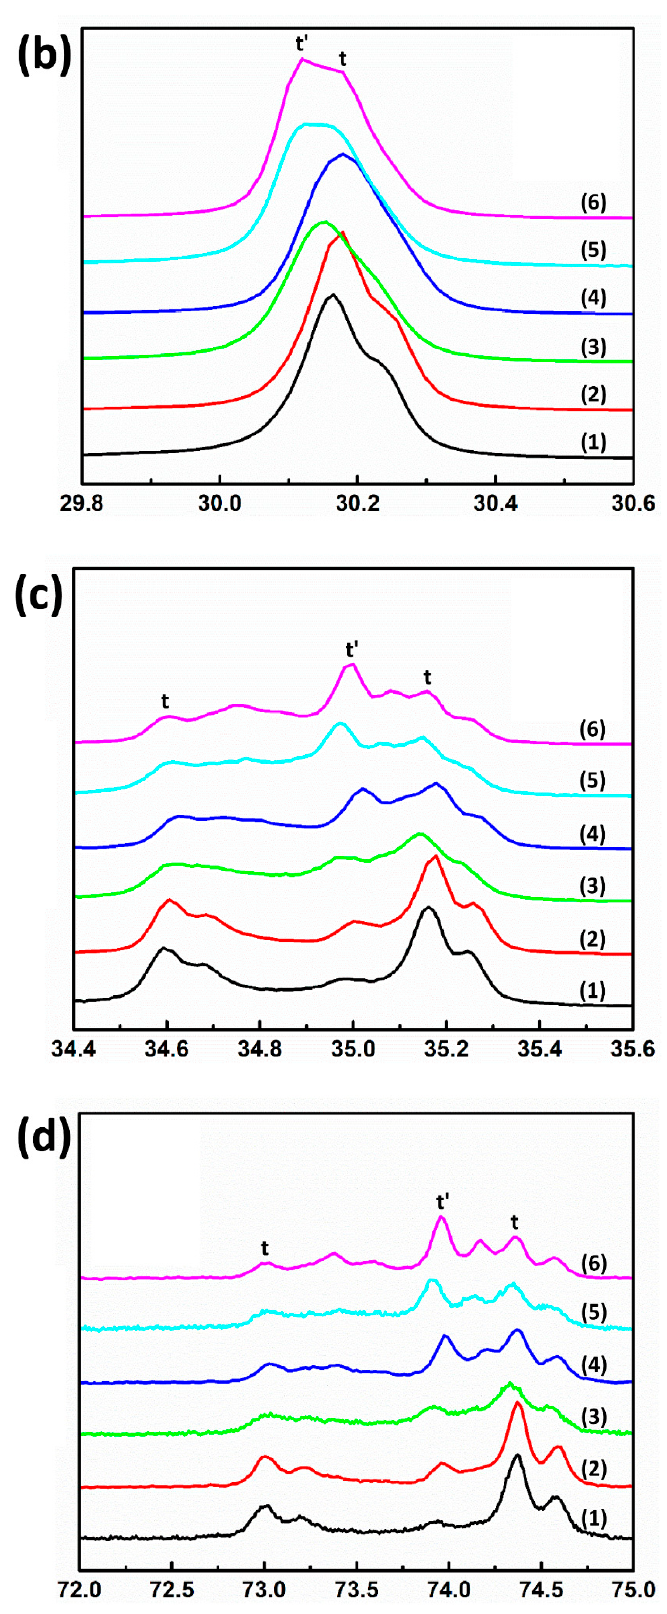
Figure 4. ( a ) The 25 ◦ –80 ◦ 2 θ range of XRD patterns of each zirconia group. Expanded view of the ( b ) 29.8–30.6, ( c ) 34.4–35.6, and ( d ) 72.0–75.0 2 θ